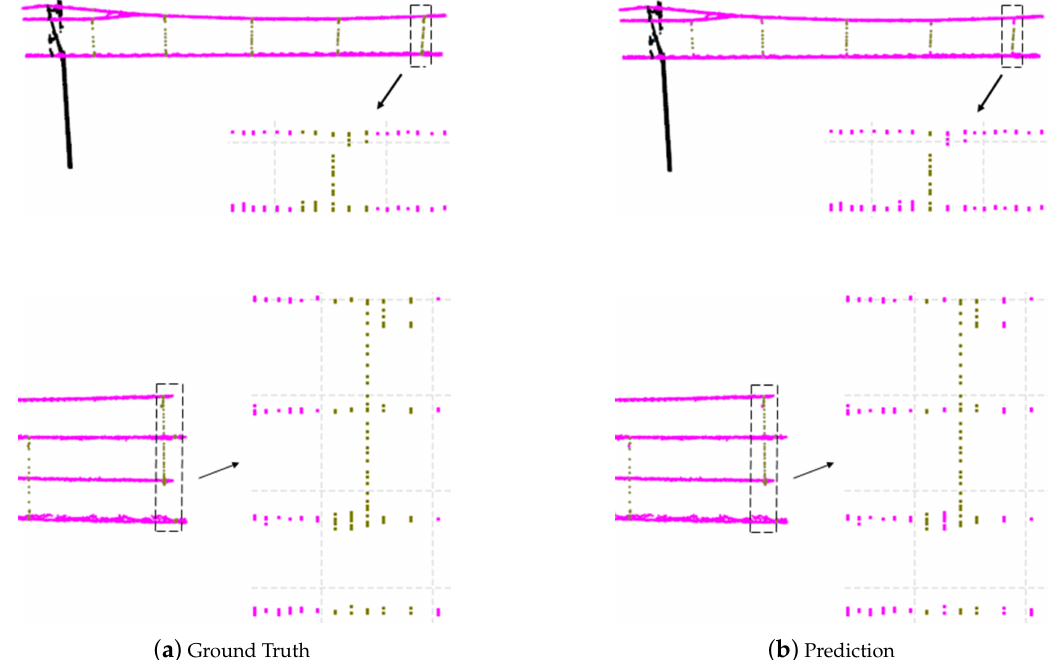
Figure 11. Classification results. The first column is the ground truth, and the second is prediction. The point clouds in a single frame are set to the same color based on the category of the single frame (wire in magenta, dropper in dark yellow, and pole in black). The arrows point to the projection of the point clouds near the dropper on the YZ plane (the coordinate system is the one of the collected